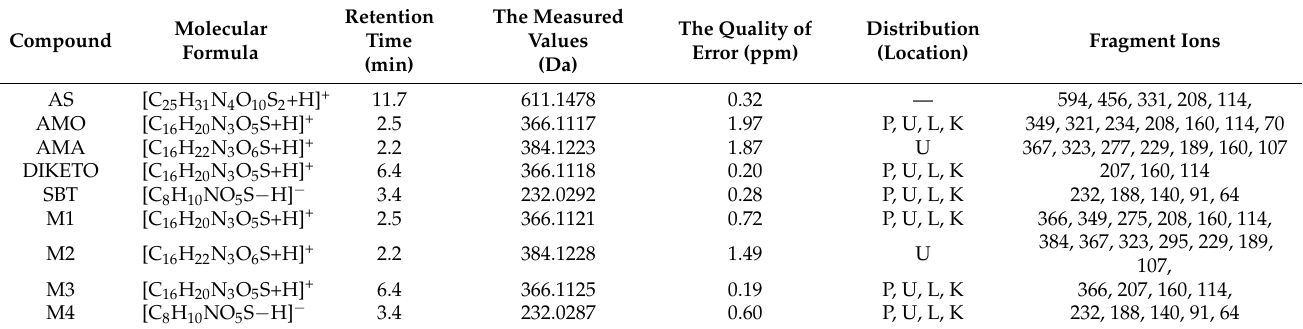
Table 2. Molecular formulas, retention times, measured molecular weights, mass errors, and fragment ions for AS and its